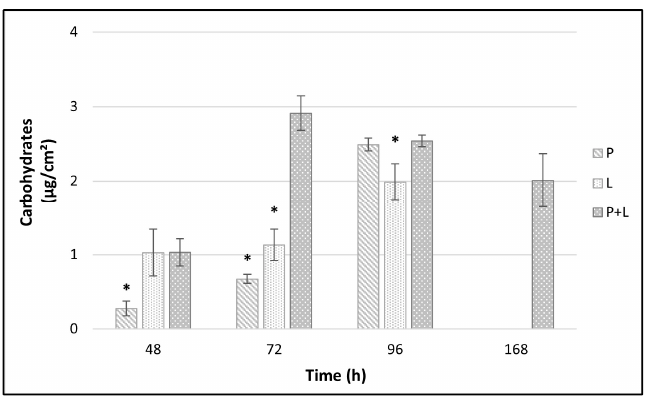
Figure 4. Carbohydrates amount (µg/cm 2 ) from L. monocytogenes LM5 and P. fluorescens pf5 bio- films on SS coupons in mono- and dual-species at 12 °C for 168 h. The results indicate the average of three values and the bars indicate the standard deviation. The asterisk (*) means statistically significant difference between the mono- and dual-species of each strains for the same incubation time (* p < 0.05). P: P. fluorescens in single-species; L: L. monocytogenes in single-species; P + L: L. monocytogenes and P. fluorescens in dual-species. monocytogenes and P. fluorescens in